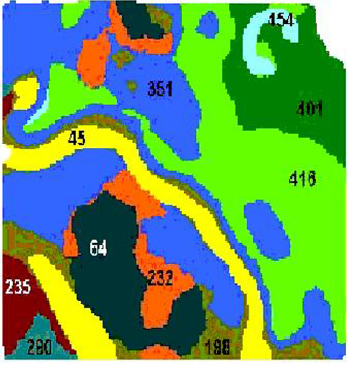
FIGURE 10. N recommendation (urea